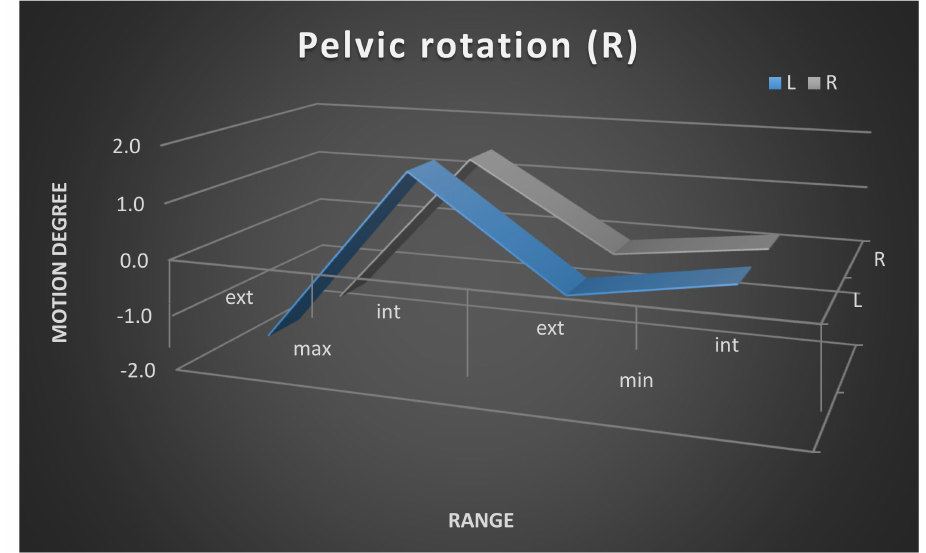
Figure 5. Pelvic rotation maximum and minimum range of movement. Left and right side comparison.